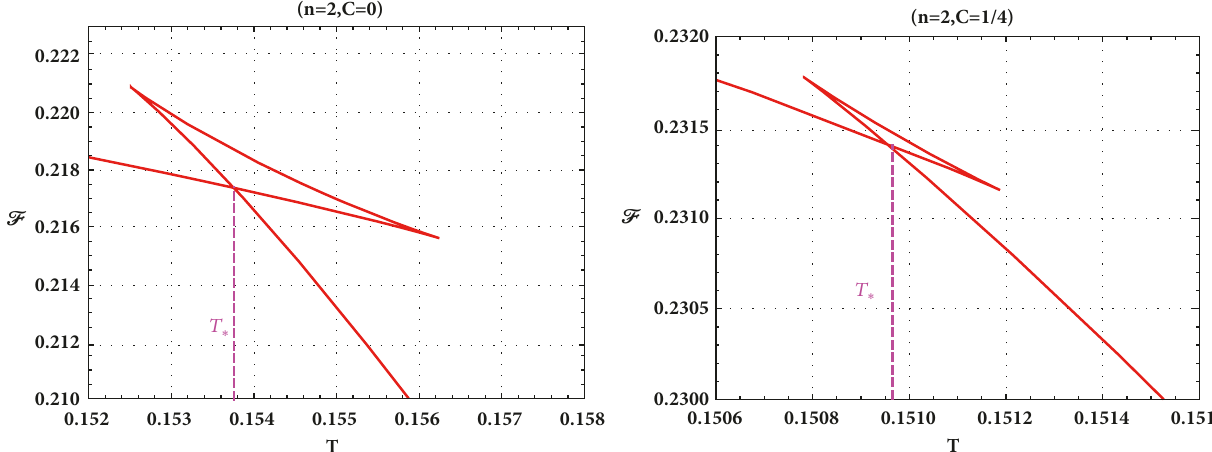
Figure 2: The Helmholtz free energy in function of the entropy for EMYM-AdS black holes for different values of the charge 𝐶 . (Left) 𝐶 = 0 . (Right) 𝐶 ̸= 0 .